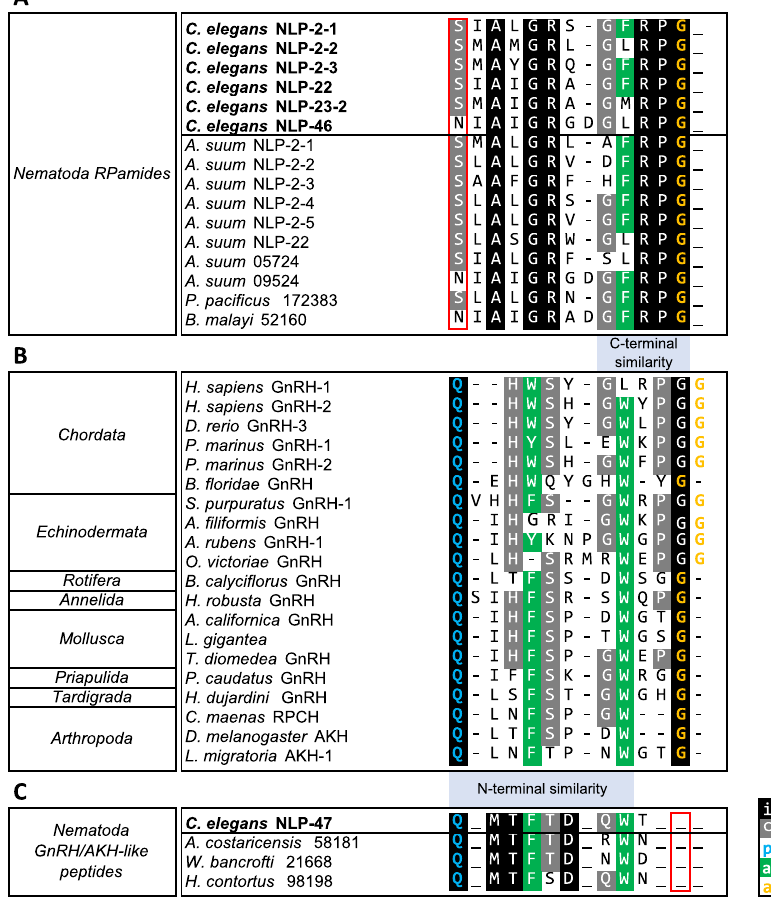
Figure 3. RPamide peptides are conserved among nematodes and share sequence similarity with GnRH/AKH peptides. ( A ) Amino acid sequence alignment of nematode RPamide neuropeptides. All have a C-terminal glycine amidation target but lack an N-terminal pyroglutamate. ( B ) Amino acid sequence alignment of GnRH/ AKH peptides across major animal phyla. ( C ) Amino acid sequence alignment of nematode GnRH/AKH-like NLP-47 peptides lacking the C-terminal glycine amidation target. For A–C , residues with a colored background are conserved in at least 50% of the sequences. Identical residues are depicted in black, conserved residues in grey and conserved aromatic residues in green. Pyroglutamate residues are indicated in blue and amidated glycine residues are indicated in orange. Absence of these modifications in nematode RPamide or GnRH peptides, respectively, are indicated by red boxes. Hyphens indicate gaps and a more elaborate alignment is depicted in Supplementary Fig.